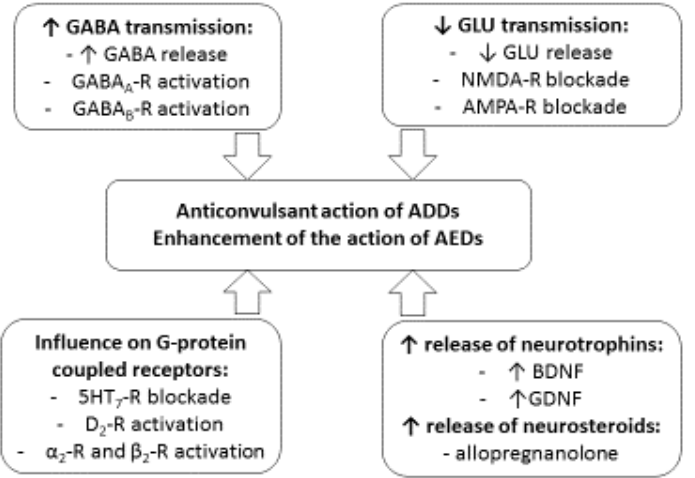
Figure 1. Probable mechanisms of the anticonvulsant action of antidepressant drugs (ADDs) and their effect on the antielectroshock action of antiepileptic drugs (AEDs).